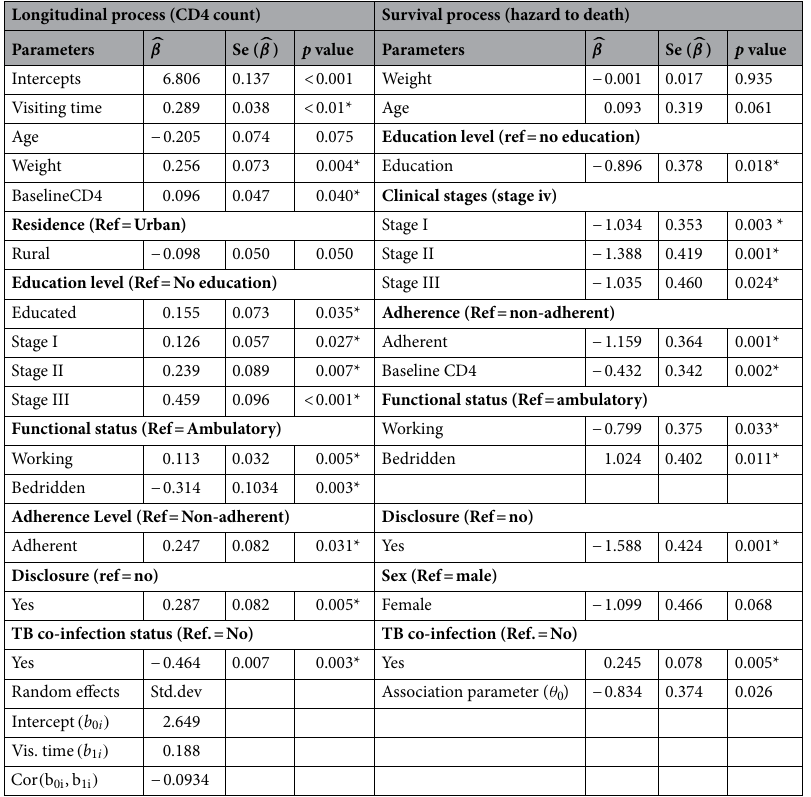
Table 4. Parameter estimates and Standard Errors under the joint modeling analysis for CD4 count and hazard to death. *stands for statistically significant variable at 5% level of